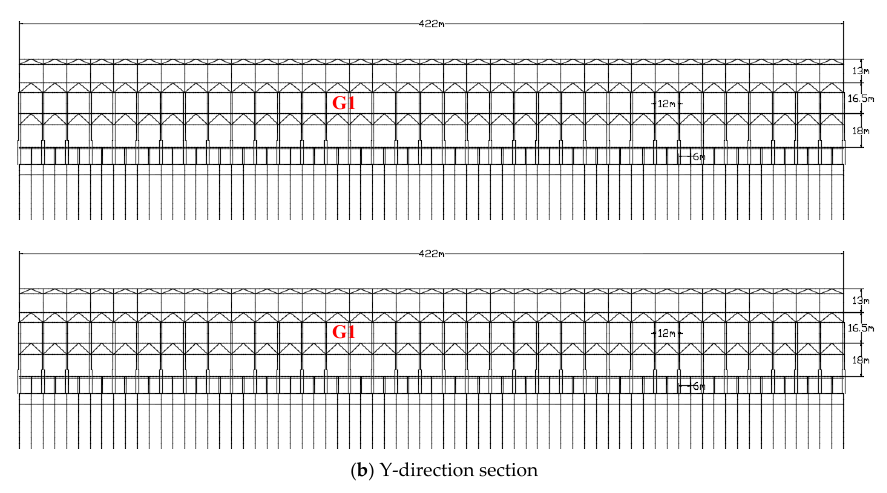
Figure 3. Two typical frames of the high-tech factories. Table 1. The steel sections in the second and third levels of the high-tech factory, as shown in Figure 3 (A572 steel with Fy = 345 MPa).